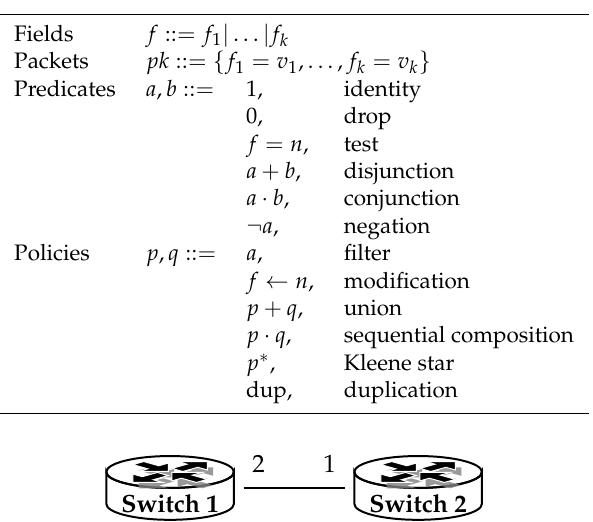
Figure 3. A simple network with a single